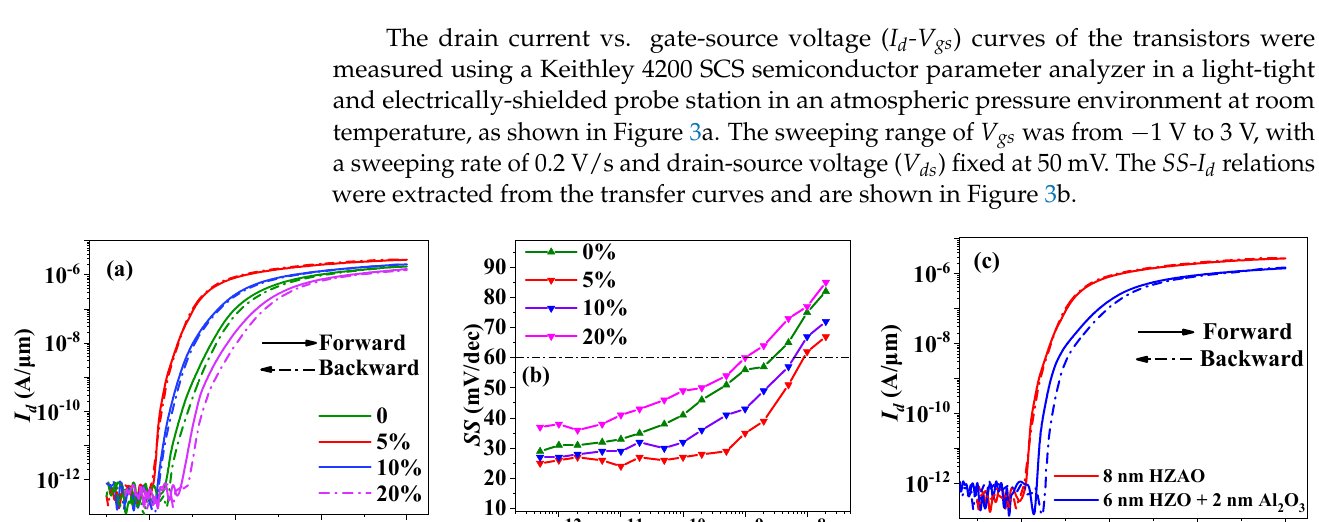
Figure 3. ( a ) Transfer curves and ( b ) SS-I d curves for the HZAO MoS 2 NCFETs with different Al contents (annealing temperature: 600 °C); ( c ) Transfer curves of HZAO NCFETs and HZO-Al 2 O 3 NCFETs. Table 1. Electrical parameters of HZAO NCFETs with different Al contents extracted from their transfer curves (annealing temperature of 600 °C).